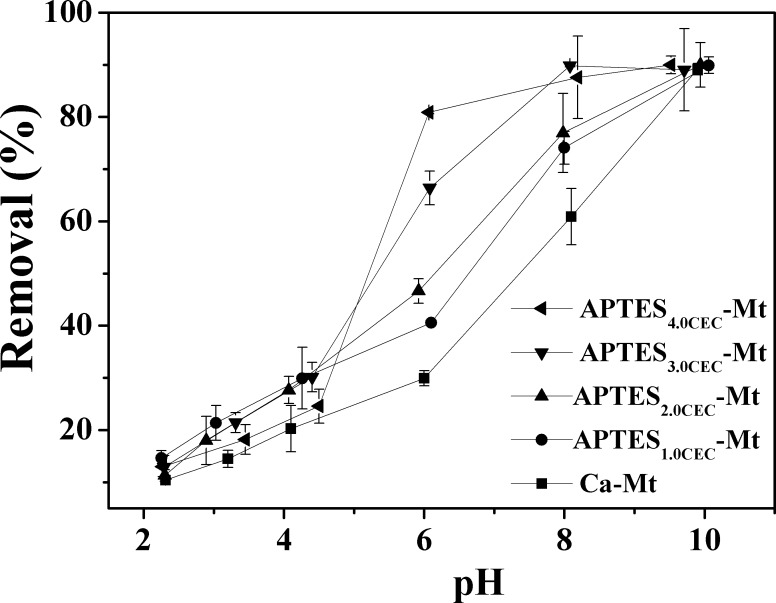
Effect of solution pH on the adsorption of Co2+ by APTES-Mts.